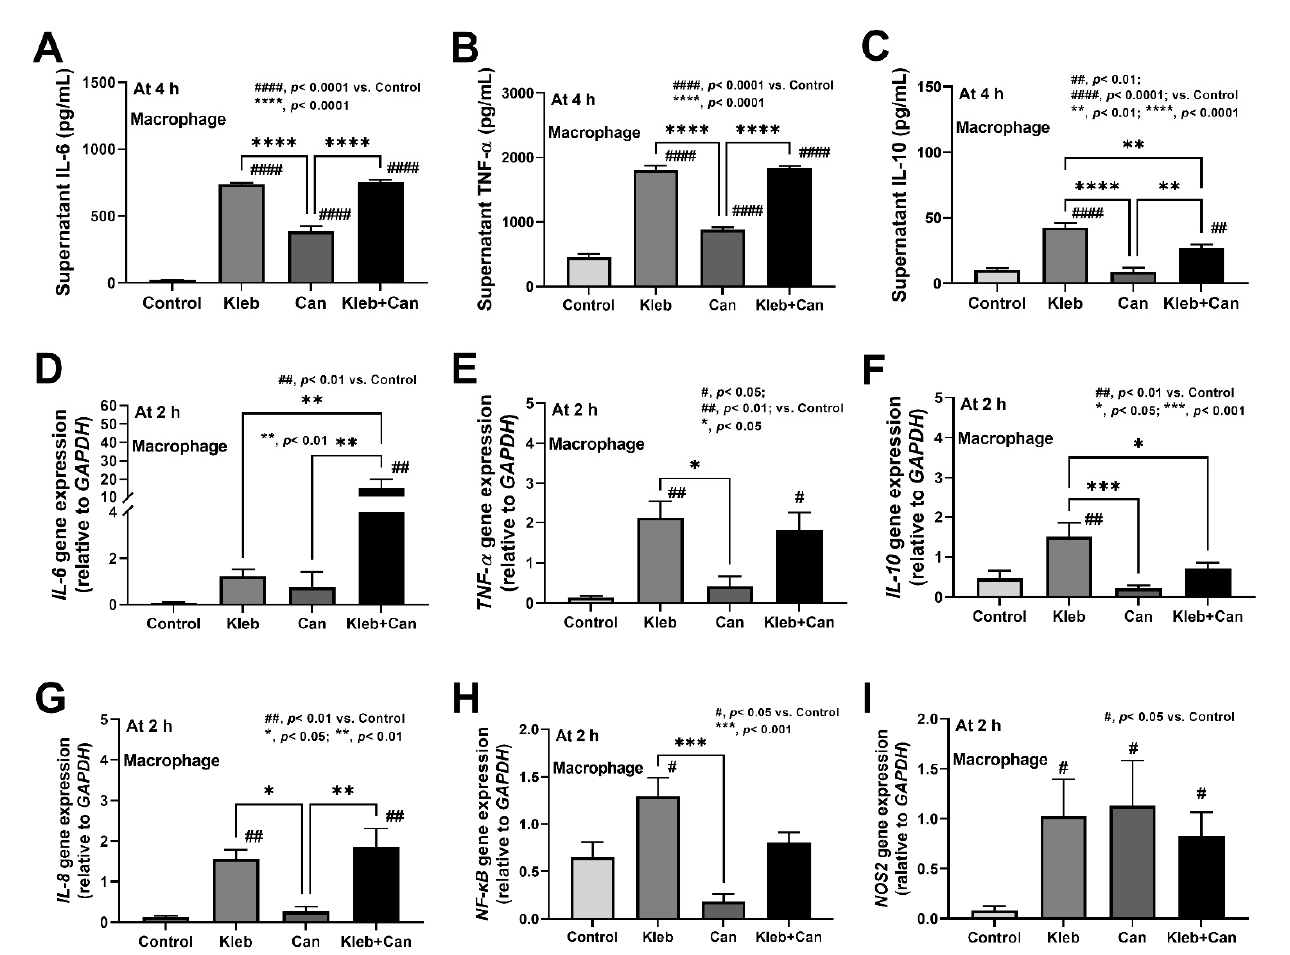
Figure 8. The characteristics of macrophages (THP-1-derived cells) after the activation by media control (control) and the preparations from K. pneumoniae (Kleb) or C. albicans (Can) alone or the combination (Kleb+Can) as indicated by supernatant cytokines (IL-6, TNF- α , and IL-10) at 72 h post- incubation ( A – C ) and the gene expression (4 h post-incubation) of the molecules of inflammation ( IL-6 , TNF- α , IL-10 , IL-8 , NF- κ B , and NOS2 ) ( D – I ). (Independent triplicated experiments were performed.) #, p < 0.05; ##, p < 0.01; ####, p < 0.0001 vs. control; *, p < 0.05; **, p < 0.01; ***, p < 0.001; ****, p < 0.0001, the indicated groups as have determined by ANOVA with Tukey’s analysis.